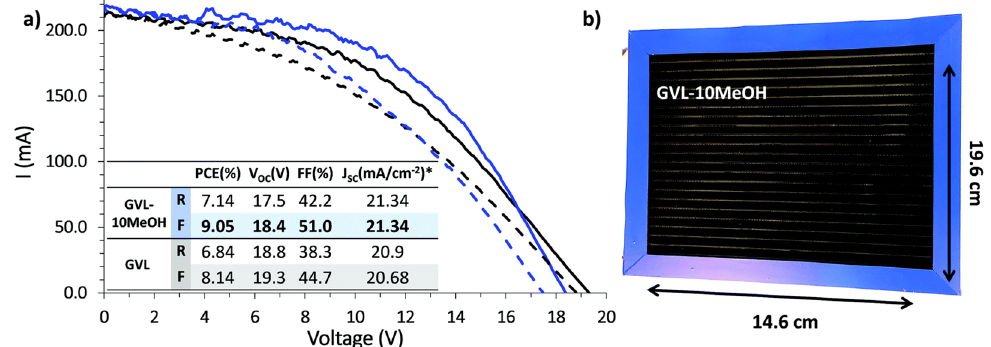
Figure 28. ( a ) I–V curves of modules fabricated with GVL only (black lines) and GVL–10MeOH precursors (blue lines), with inlaid table showing measured photovoltaic parameters (* Jsc as calcu- lated for one cell of the module). ( b ) Photograph of the GVL–10MeOH module with dimensions labeled [104]. (Reproduced from Ref. [104], 10.1039/D1MA00975C, under the terms of the CC BY [3.0] license.).